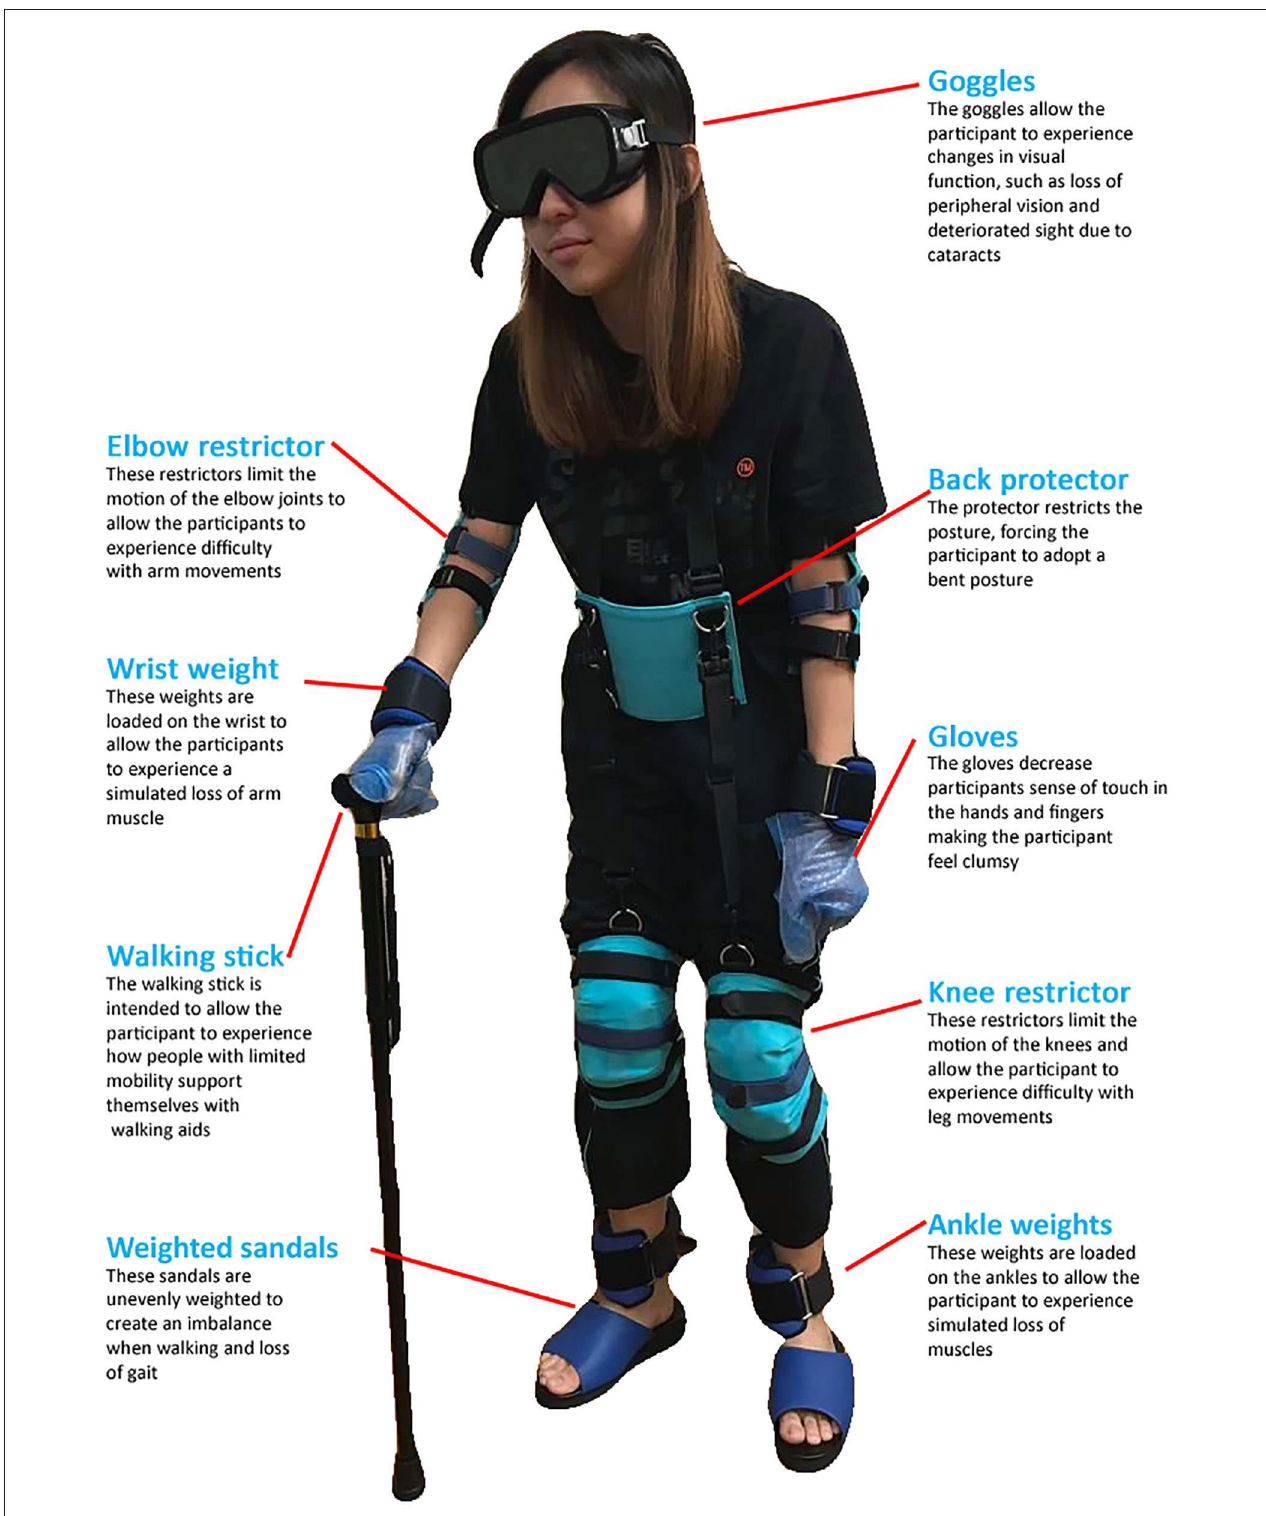
FIGURE 1 | The full setup of aging